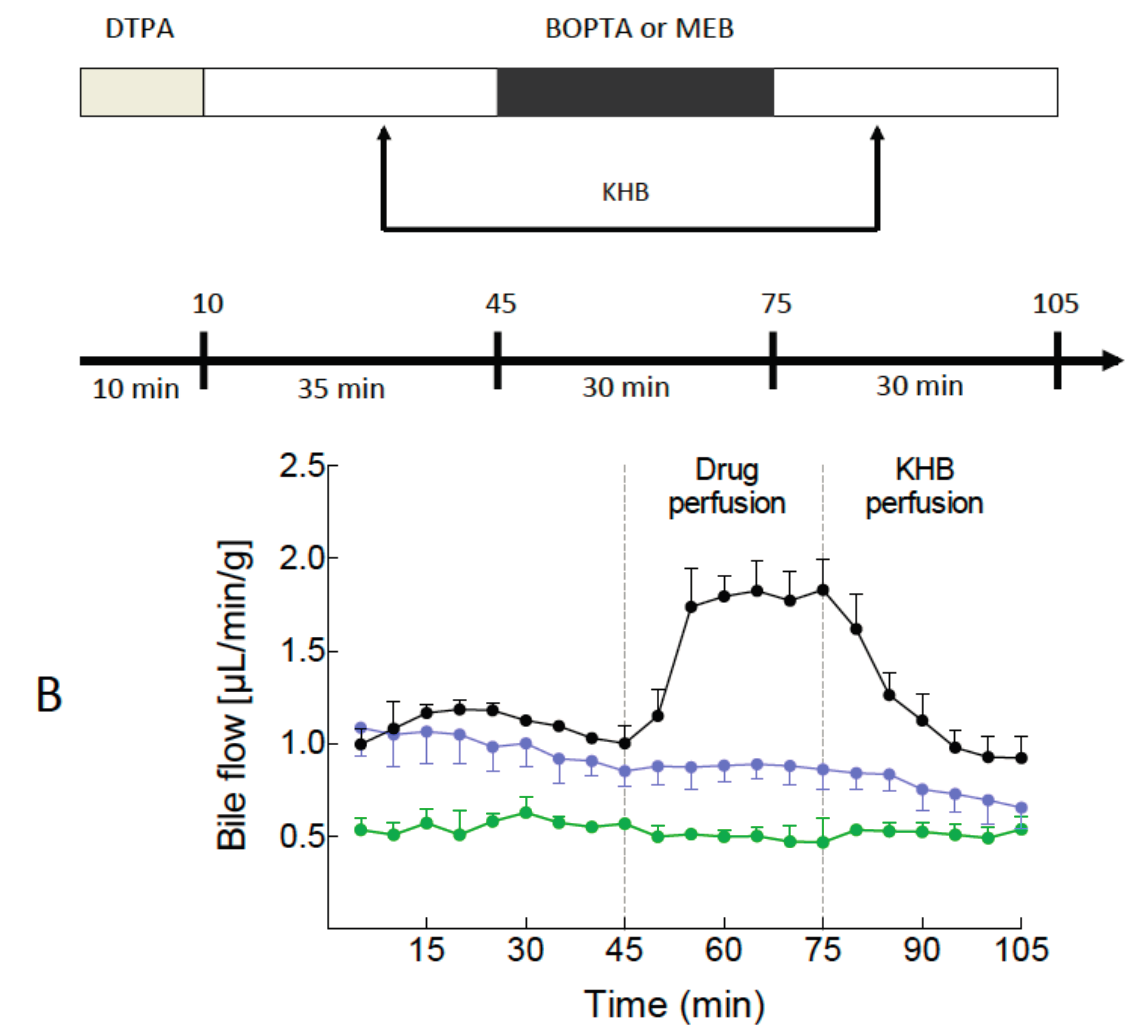
Figure 1. ( A ) Diethylenetriaminepentaacetic acid (DTPA), gadobenate dimeglumine (BOPTA), and mebrofenin (MEB) solutions perfused over time. DTPA is an extracellular contrast agent used in liver imaging that distributes into sinusoids and intersititum while BOPTA and MEB also enter into hepatocytes following extracellular distribution. DTPA was labelled either with 153 GdCl 3 or 99m Tc while BOPTA was labelled with 153 GdCl 3 and MEB with 99m Tc. 153 Gd-DTPA and 153 Gd-BOPTA were diluted in Krebs-henseleit bicarbonate (KHB) solution to obtain a 200-µM concentration. 99m Tc-DTPA and 99m Tc-MEB were diluted in KHB solution to obtain a 64-µM concentration. Three groups of rat livers were perfused: (1) Livers isolated from normal rats and perfused with 200 µM DTPA and 200 µM BOPTA (BOPTA group, black circles, n = 5); (2) livers isolated from rats lacking Mrp2 and perfused with 200 µM DTPA and 200 µM BOPTA (BOPTA-TR group, green circles, n = 3); and (3) livers isolated from normal rats and perfused with 64 µM DTPA and 64 µM MEB (blue circles, n = 5); and ( B ) Bile flow rates (µL/min/g of liver) in the three experimental groups over time